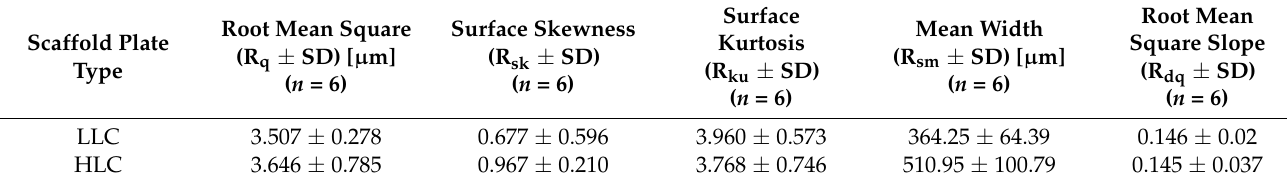
Table 8. Amplitude (Rq, Rsk, and Rku), spacing (Rsm), and hybrid (Rdq) roughness parameters of microsurface topography.